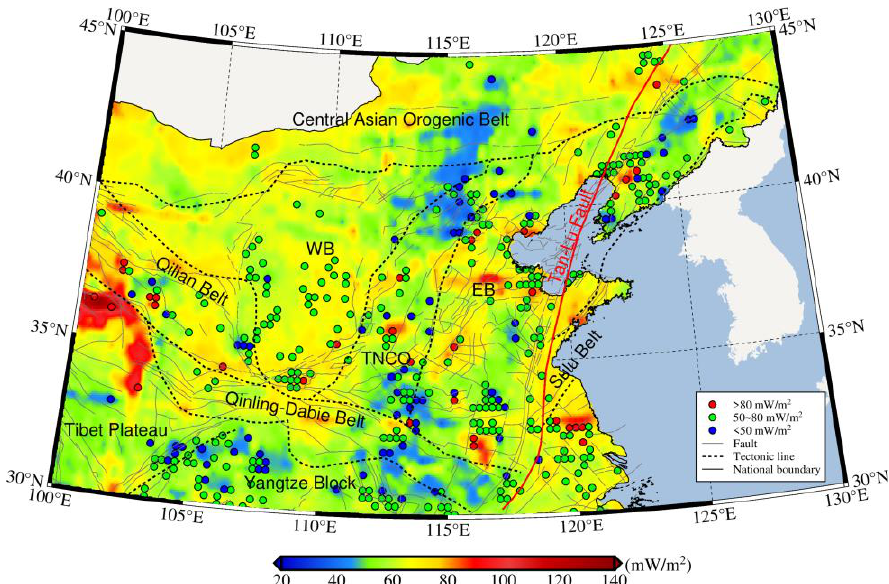
Figure 7. Heat flow prediction results with regional tectonics. The red solid line delineates the most significant fault in the NCC, the north-south trending Tan-Lu Fault. Gray solid lines indicate minor faults [32 – 34]. Black dashed lines indicate the boundaries of different tectonic units. WB: Western Block; TNCO: Trans-North China Orogenic Belt; EB: Eastern Block.